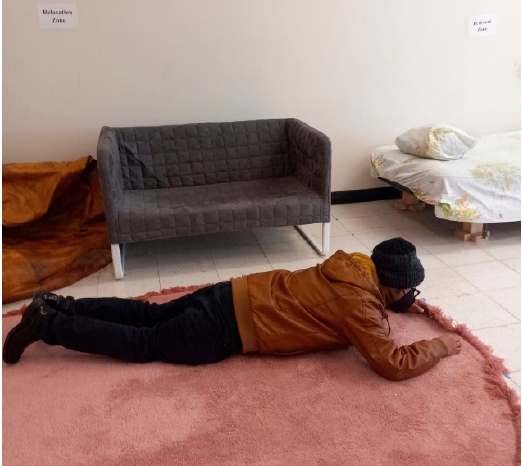
Figure 12. A participant falling in the relaxation zone. Here, a forward fall is demonstrated.